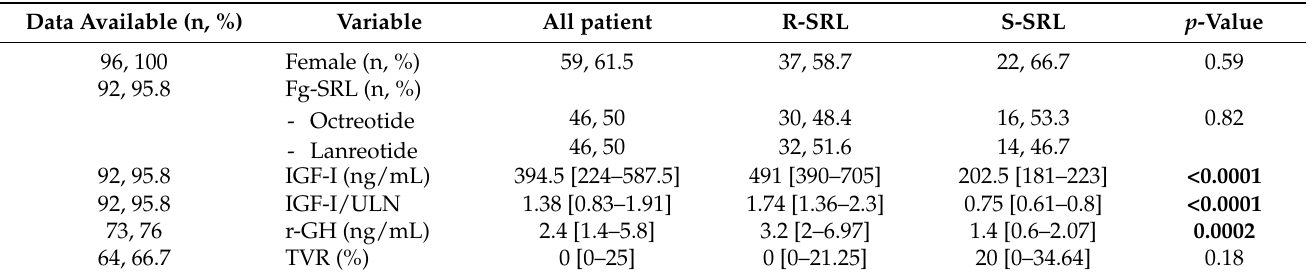
Table 1. Main characteristics of the acromegaly population (96 patients) at the recruitment.